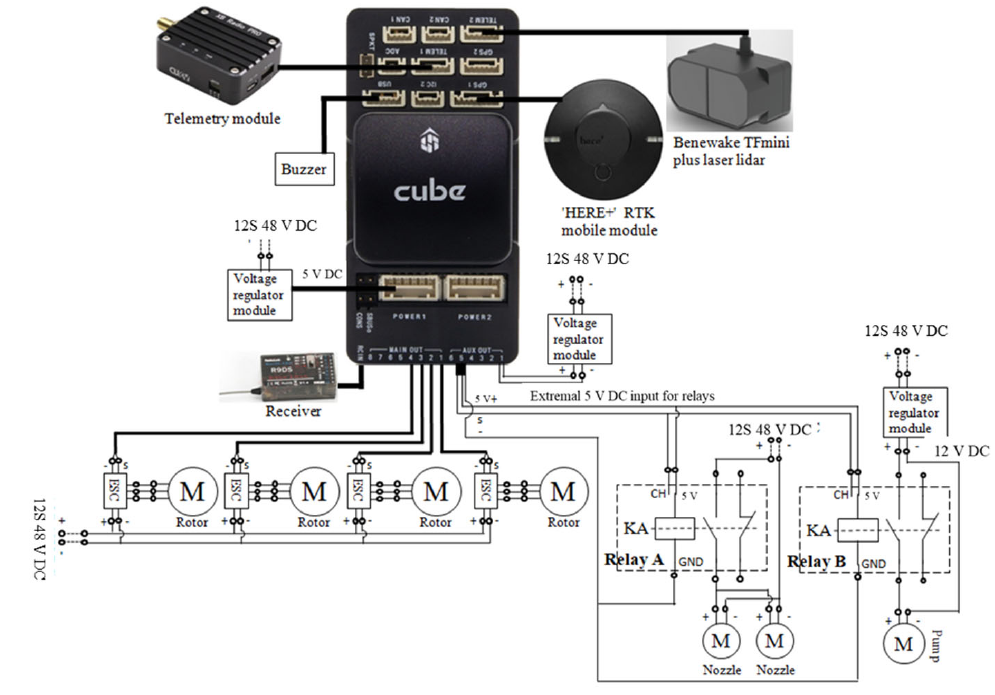
Figure 6. The electric wiring diagram of the UAV.